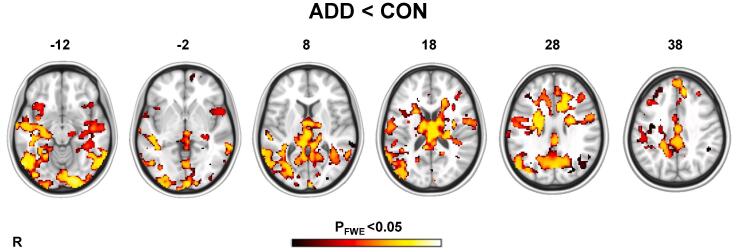
Permutation independent samples t-test analyses showing that ADD < CON group activation differences on the MID gain anticipation > neutral anticipation contrast. Images were produced after 5000 permutations in randomise using TFCE (PFWE < 0.05), controlling for study site. The bar corresponds to PFWE < 0.05 and lower. The structural image represents the MNI152 average normal brain with corresponding horizontal coordinates (inferior–superior). R = right hemisphere.